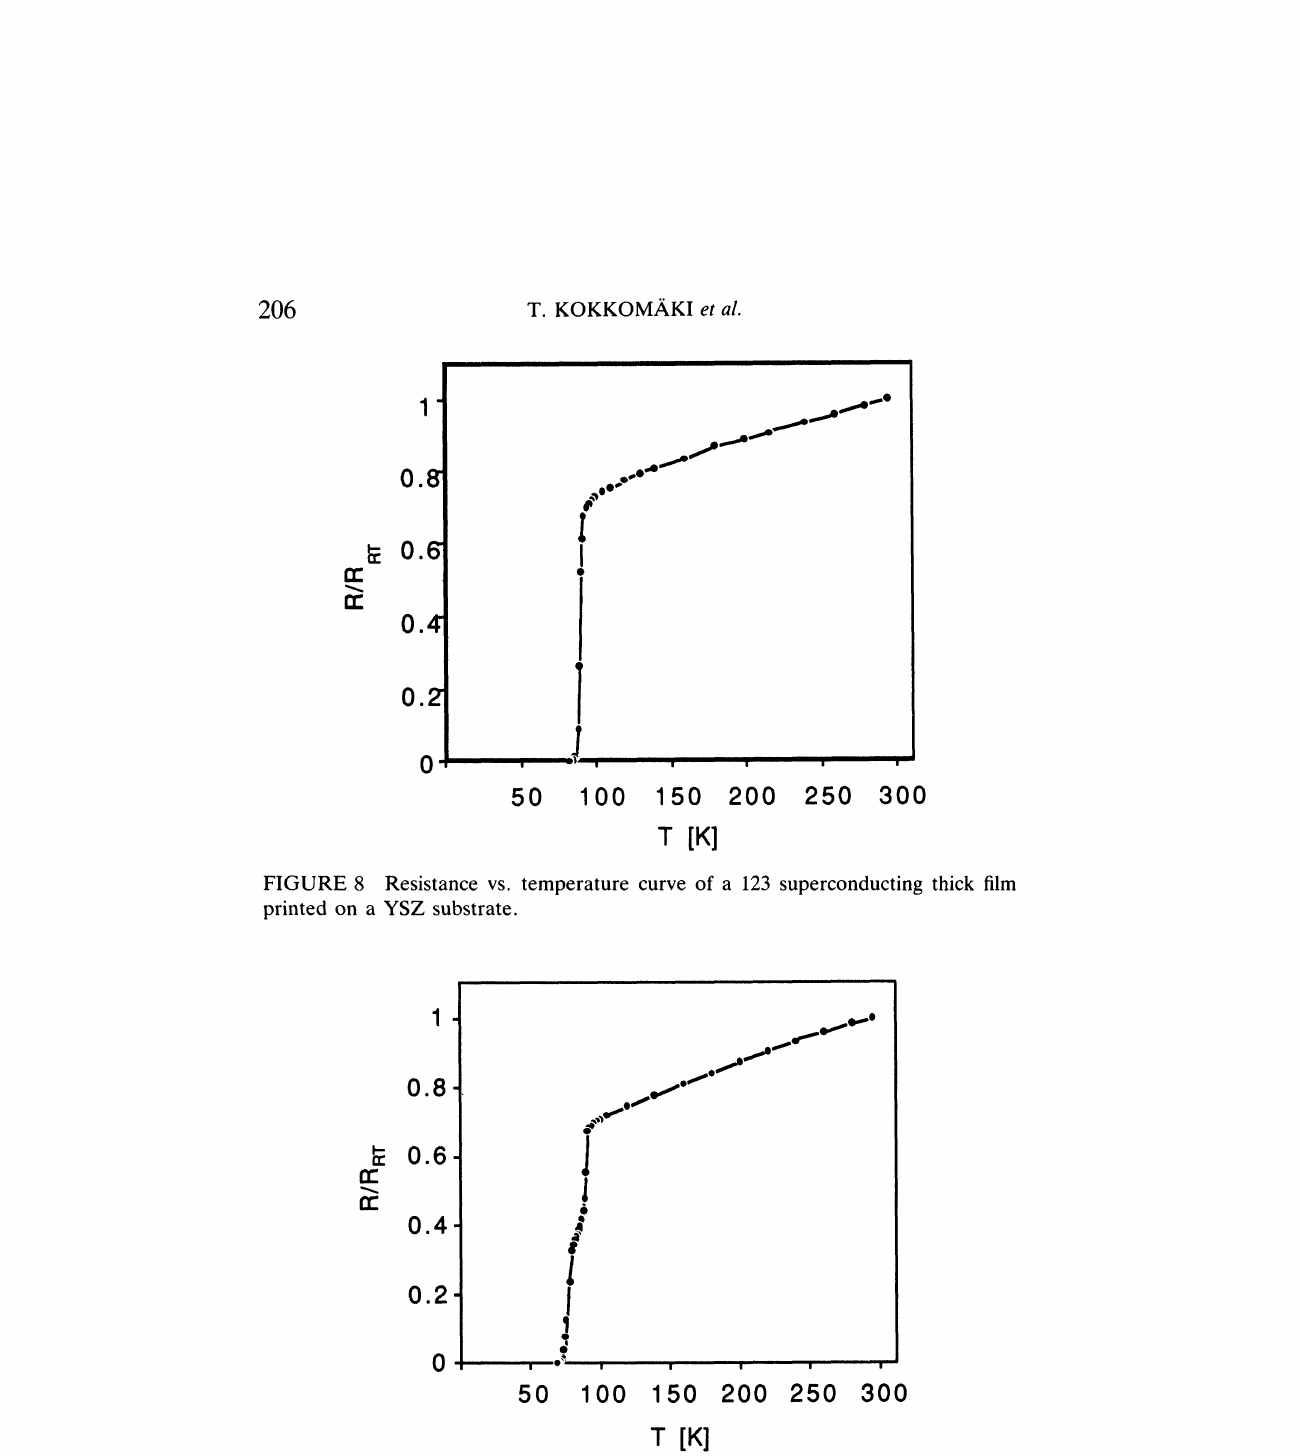
FIGURE 9 Resistance vs. temperature curve of a 123 superconducting thick film printed on an MSZ